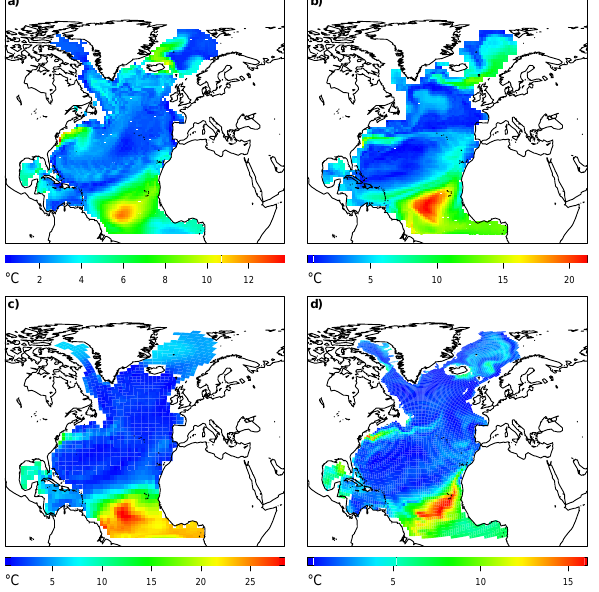
Fig. 6. Euclidean distance between LGM July temperatures over the top 300m of the water column and the nearest analogues in the PI ocean for four CMIP5 models: (a) GISS, (b) MIROC, (c) IPSL, (d) MPI.